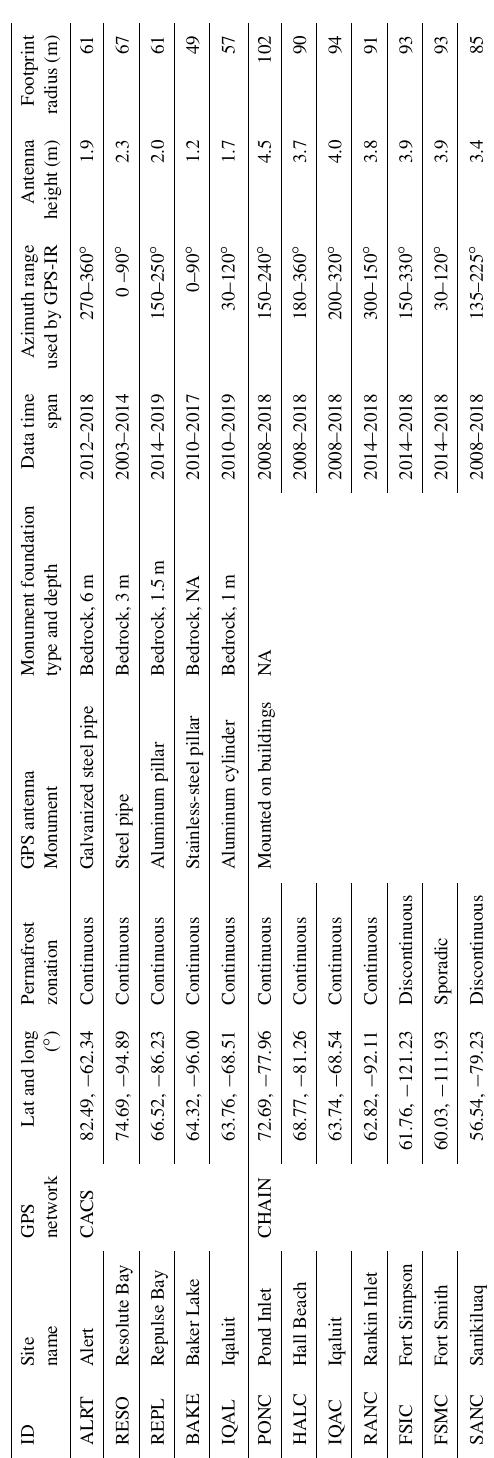
These five sites are all located in the Canadian Arctic.